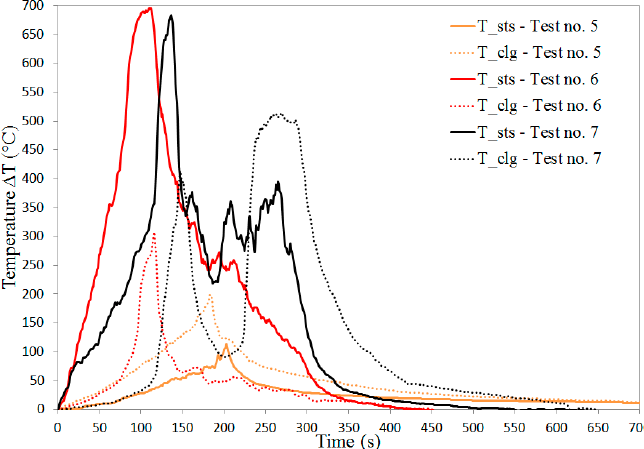
Figure 10. Timber–bench and ceiling surface temperature trends for Tests no. 5–7. Figure 10. Timber-bench and ceiling surface temperature trends for Tests no. 5–7.